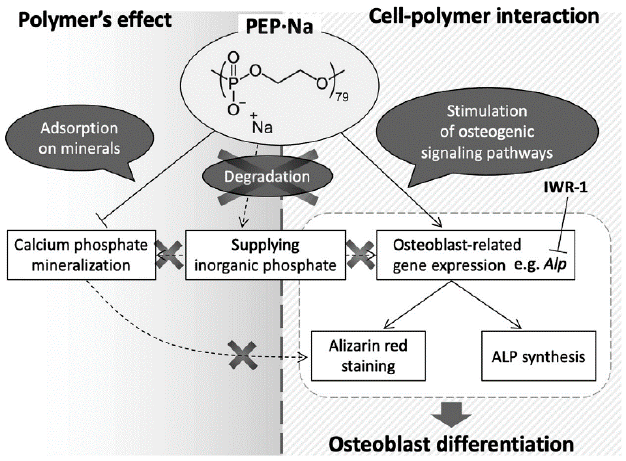
Figure 13. Schematic illustration of effects of Na-PEP on osteoblast differentiation of MC3T3-E1 cells. Reprinted with permission from [126]. Copyright (2021) Elsevier B. V.